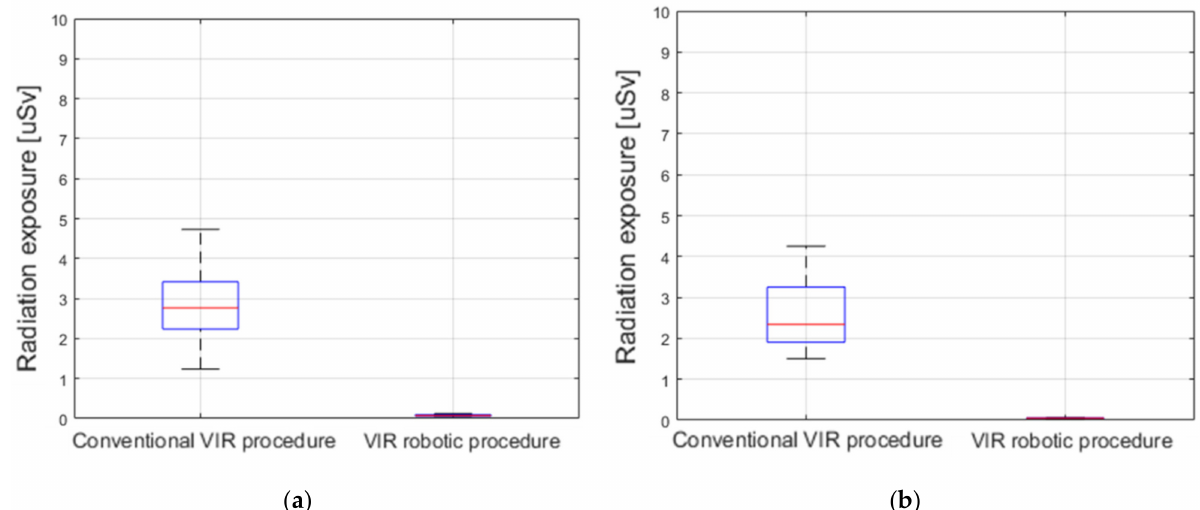
Figure 13. Measurement results of the radiation exposure to operators during conventional and robotic VI procedures. The measured radiation exposure during the procedure for ( a ) right renal artery target 1; and ( b ) right renal artery target 2.